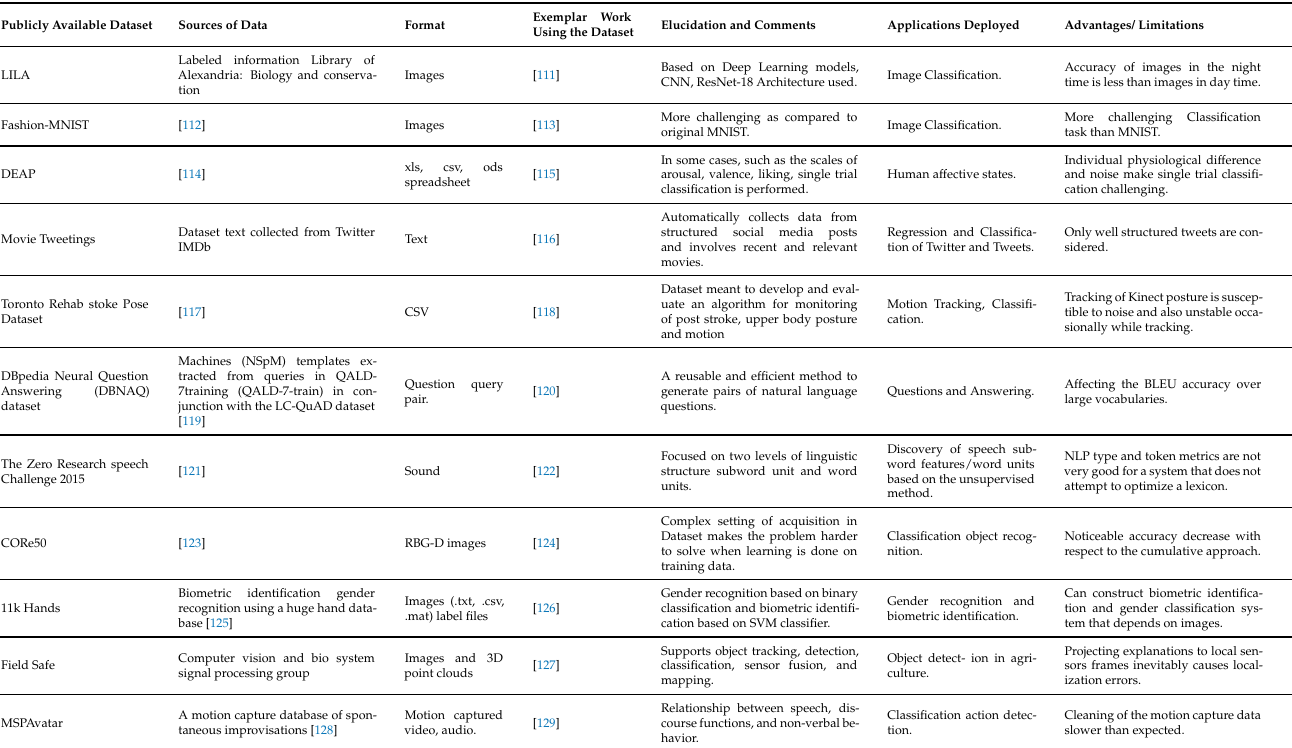
Table 5. Publicly Accessible Datasets for Intelligent